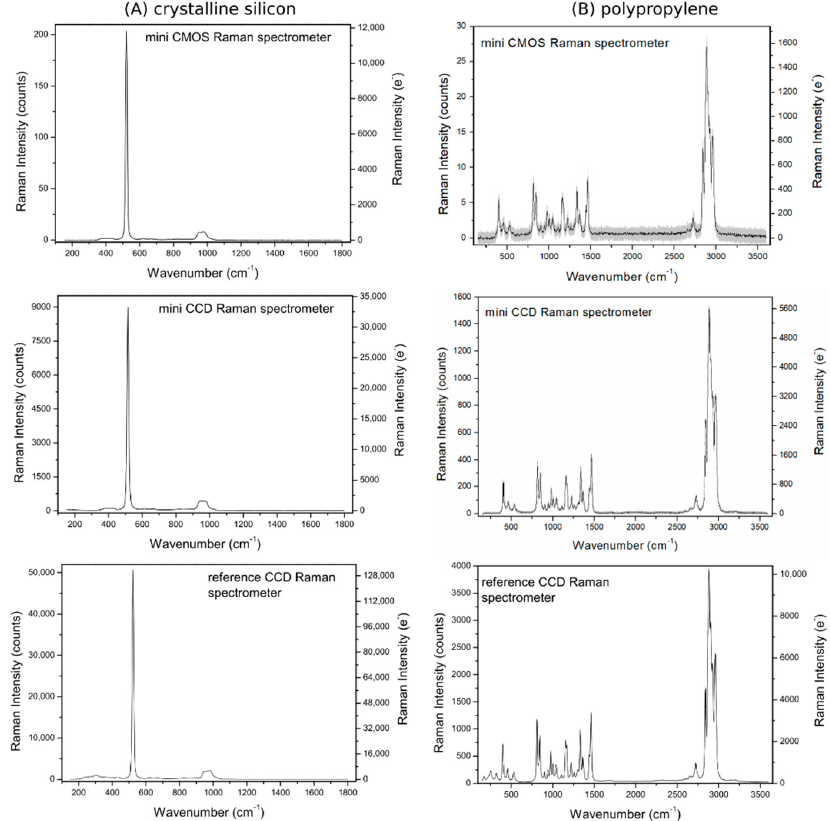
Figure 1. Dark current corrected mean Raman spectra of ( A ) crystalline silicon wafer and ( B ) polypropylene measured with the three platforms (1 s acquisition time, 100 single spectra). For better comparison the Raman intensity is expressed both in counts and e − .